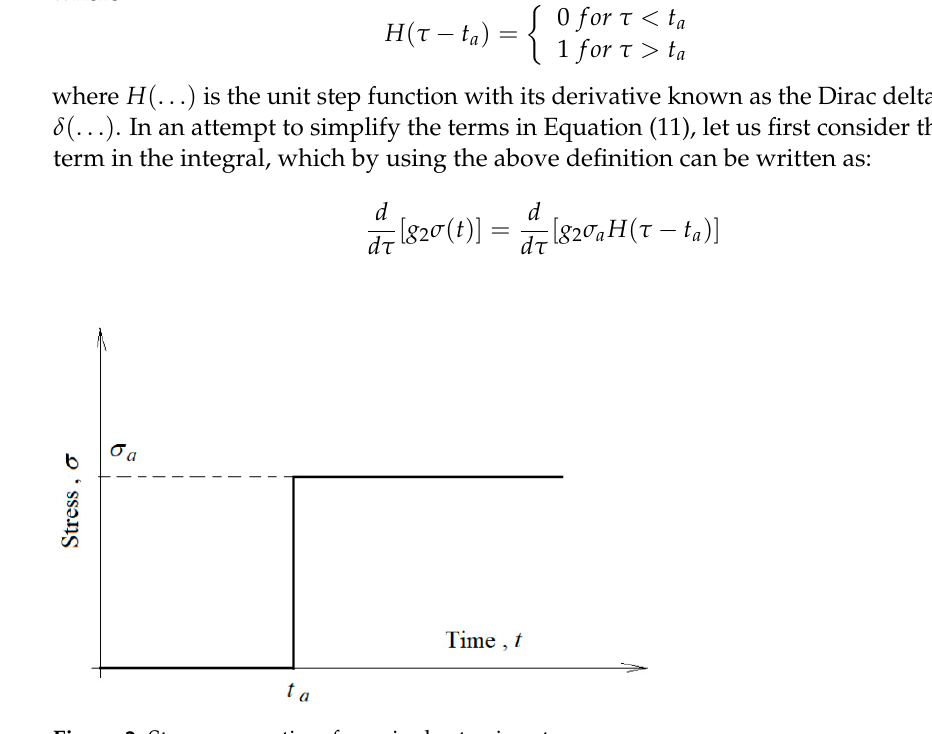
Figure 2. Stress versus time for a single-step input.